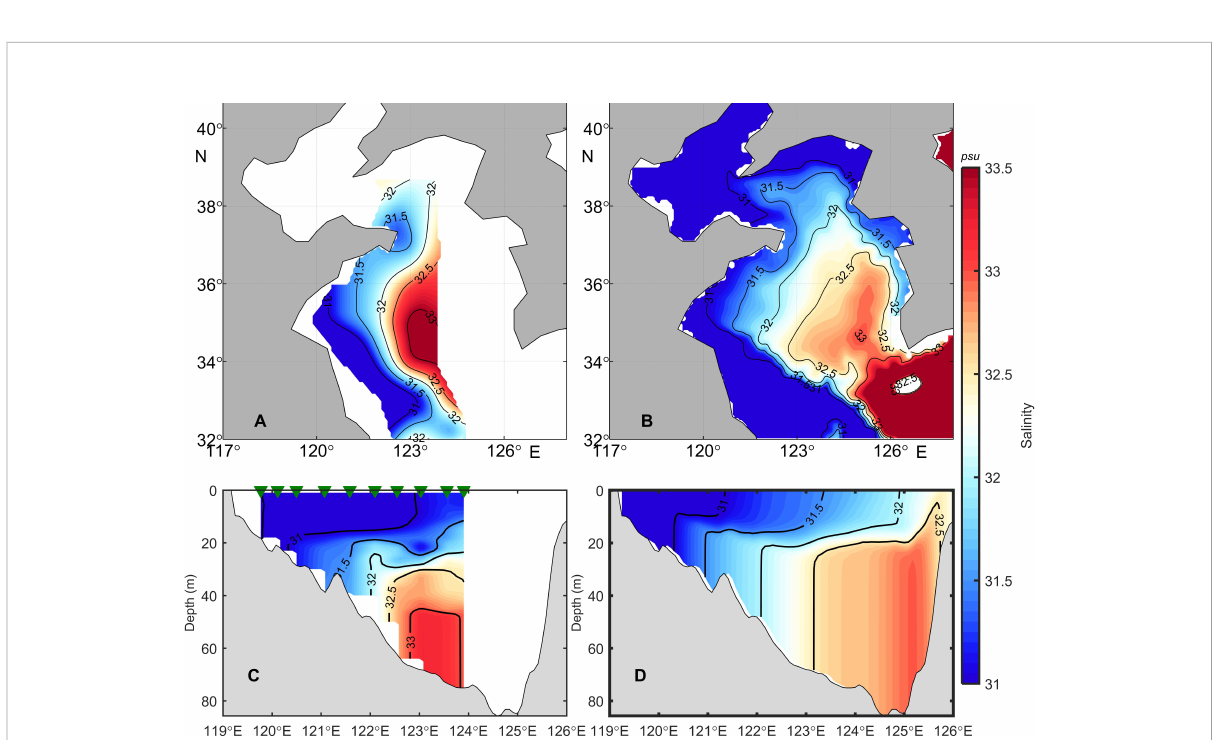
FIGURE 3 Bottom salinity distribution of in situ observations (A) and monthly mean model results (B) in August 2015. Salinity distributions of in situ observations (C) and monthly mean model results (D) at the 35°N section in August